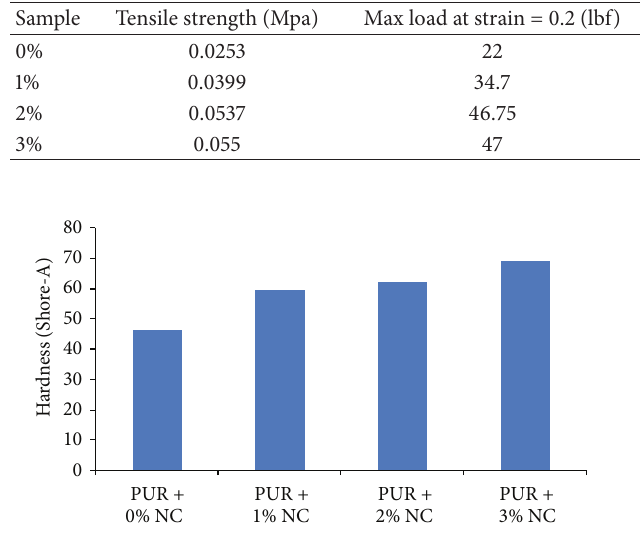
Figure 7: Hardness of PUR-nanoclay